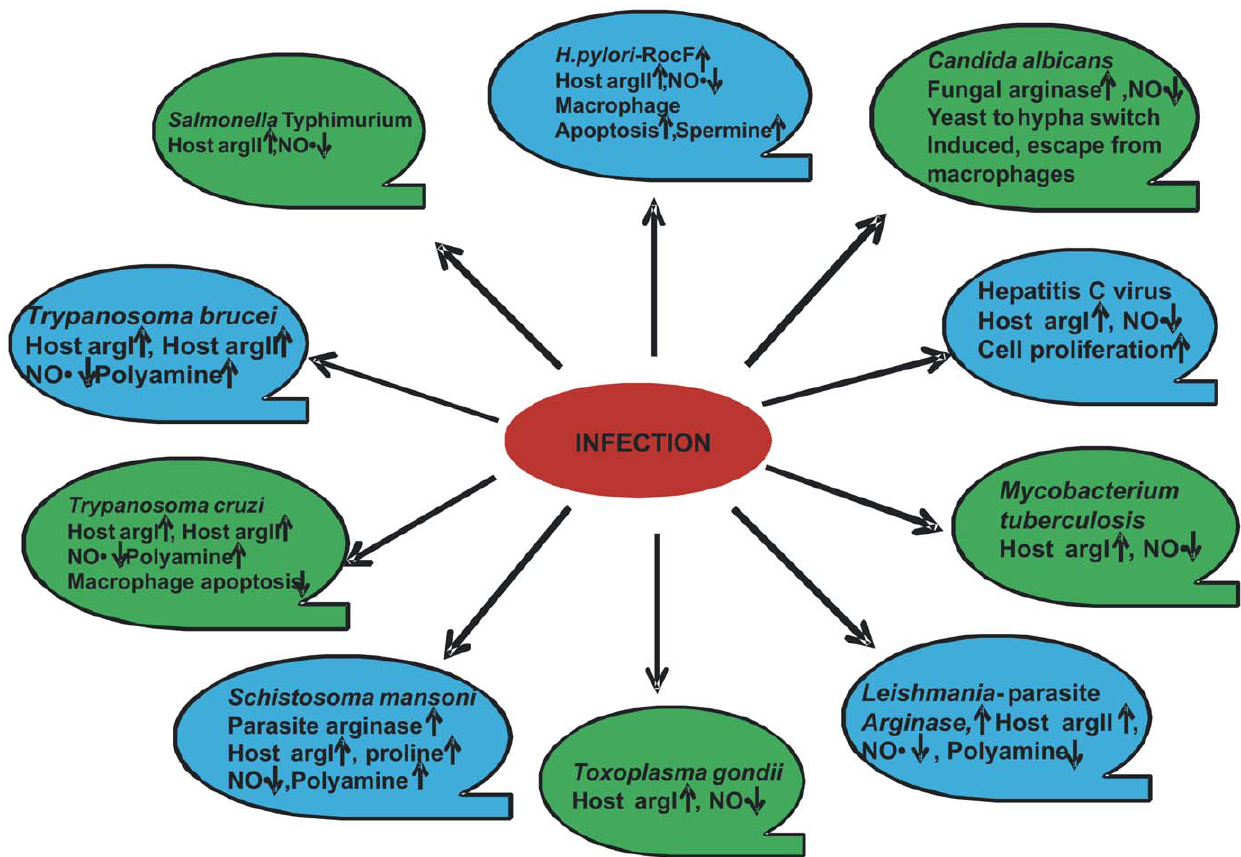
Figure 2. Modulation of arginase by various pathogens.